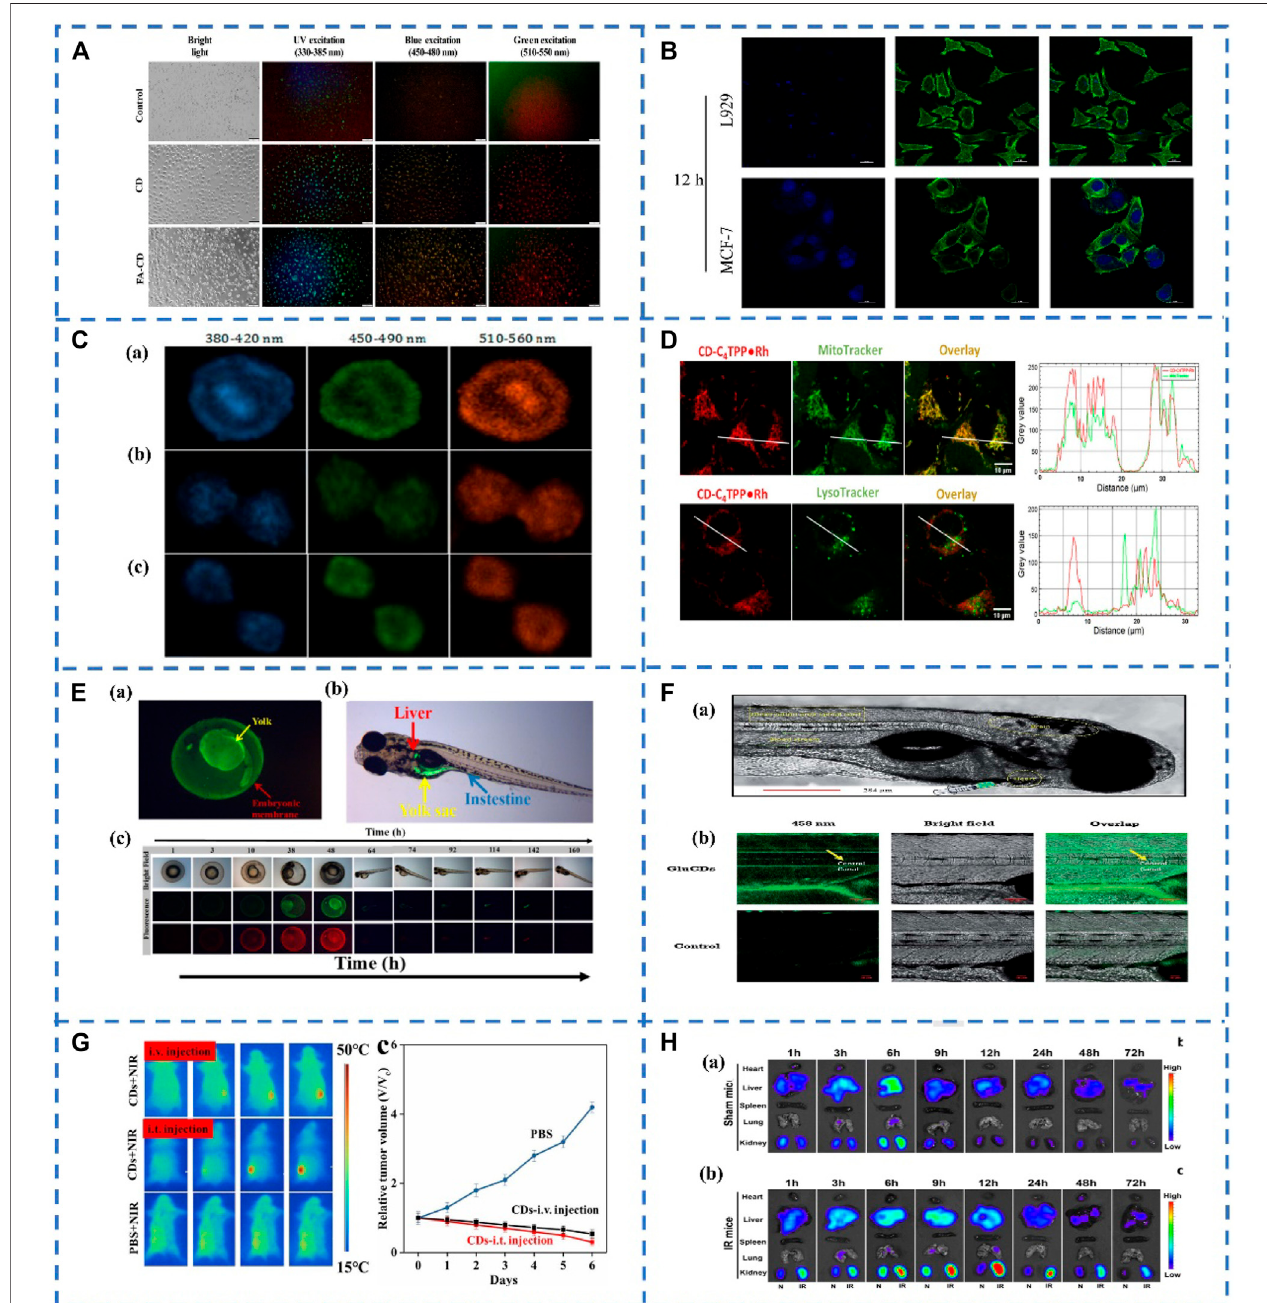
FIGURE 1 | (A) Bioimaging of CDs and FA-CDs in cancer cells (Gudimella et al., 2021). (B) Flow cytometry pro fi les of MCF-7 cells and L929 cells treated with the CDs-PEI-AS1411 for 12 h (Kong et al., 2020). (C) Mitotic cells stained by N-CDs visualizing chromosome aggregation through progression of mitosis ’ prophase, metaphaseand anaphase,respectively(Zhangetal.,2020). (D) N-CDsinternalizationinliveMDA-MB-231cells.(Kaminarietal.,2021); (E)(a) Uptakeanddistributionof WCDs in zebra fi sh embryos; (b) The distribution of WCDs in zebra fi sh larvae; (c) Fluorescence microscopy images of uptake of WCDs in zebra fi sh growth cycle (ZonglinLiuetal.,2021). (F)(a) Confocalimagesofwild-typezebra fi shshowingtheinjectionroute,heart,bloodstream,CNSandobservationarea(centralcanalofspinal cord). (b) Accumulation of GluCDs-F in the CNS of zebra fi sh (Seven et al., 2021). (G) Representative infrared thermal images of tumor-bearing mice with intravenous injection, intratumoral (i.t.) injection of CDs (50 μ l, 20 mg/ml) and PBS (50 μ l) into the tumor site under 808 nm laser irradiation and time course change in the relative volume after treatment by using CDs and PBS (Li et al., 2019) (H) In vivo bio-distribution of PDA-CDs in both ischemia-reperfusion (IR)-AKI and healthy mice.Representative fl uorescence images (excitation: 410 nm, emission: 500 nm) of major organs from shammice (a) and IR-injured mice (b) at different times after PDA-CDs intravenous injection (Gao et al., 2020).